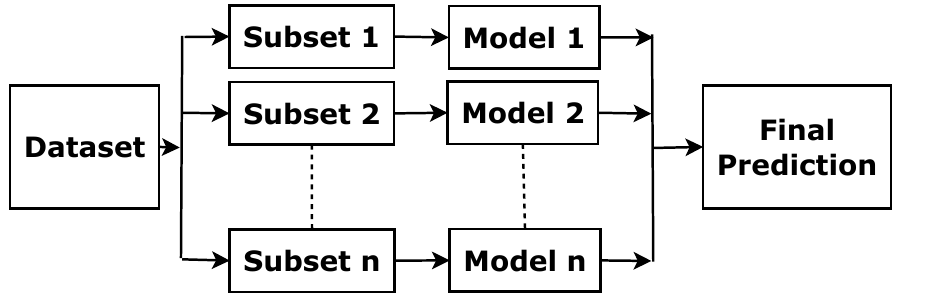
Figure 3. The concept of boosting.